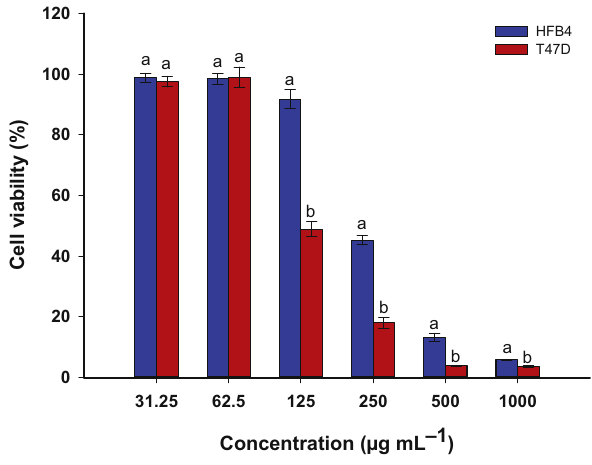
Figure 7: In vitro cytotoxicity of CuO - NPs against breast cancer cell lines ( T47D ) and normal cell lines ( HFB4 ) detected by MTT assay